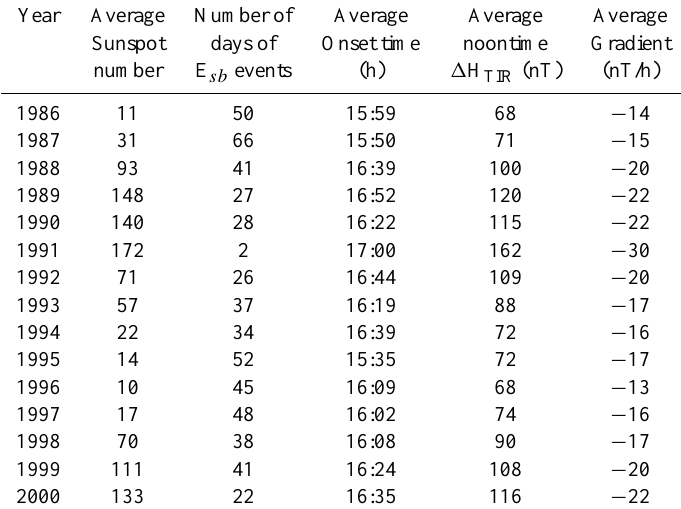
Table 1. The number of days of E sb events during the solstitial months of 1986–2000 and their average characteristics.